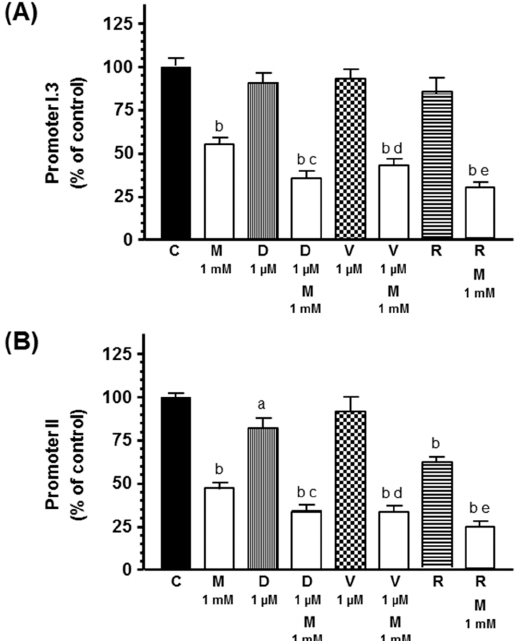
Figure 8. Effects of melatonin on docetaxel-, vinorelbine-, and radiation-induced changes on (A) aromatase promoter I.3 and (B) aromatase promoter II mRNA expression. Data are expressed as the percentage of control group (mean ± SEM). a, p < 0.05 vs. C; b, p < 0.001 vs. C; c, p < 0.001 vs. D (1 µM); d, p < 0.001 vs. V (1 µM); e, p < 0.001 vs. R. C: control, M: melatonin, D: docetaxel, V: vinorelbine, R: radiation.